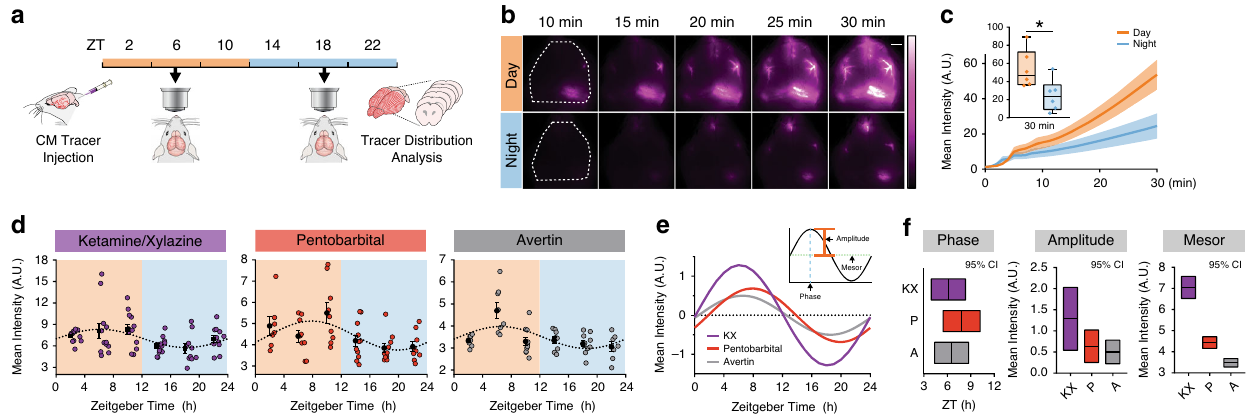
Fig. 1 Glymphatic in fl ux is higher during the day. a Schematic of experiment. b Representative images for in vivo recordings of CSF tracer in fl ux after injection in the CM either during the day (orange) or night (blue) under ketamine/xylazine (KX) anesthesia. Dotted white line indicates region of quanti fi cation in c . White scale bar: 2 mm. c Mean pixel intensity in arbitrary units (A.U.) over 30 min post CM injection. Thick lines indicate group means with SEM outlined in shaded regions. The inset is the magnitude of fl uorescence at 30 min with boxplots, minima is minimum value, maxima is maximum value, center is median and quartiles shown by box and whiskers, individual animals represented as colored dots, two-sided t test, p = 0.0257. Time 0 is tracer infusion start. n = 6 mice per group. Asterisk indicates p < 0.05. d Time course of mean pixel intensity from ex vivo coronal sections under KX (violet, n = ZT22: 10 mice; ZT18: 11 mice; ZT2, ZT6, ZT10, and ZT14: 12 mice), pentobarbital (red, n = ZT2: 7 mice; ZT6, ZT10, and ZT22: 9 mice; ZT18: 10 mice; ZT14: 11 mice), and Avertin (gray, n = ZT22: 7 mice; ZT2 and ZT6: 8 mice; ZT14: 9 mice; ZT10 and ZT18: 10 mice). Each colored point is an animal, black points are mean ± SEM for each time bin. Dotted line indicates estimated cosinor curve. The light cycle is indicated by orange (day) and blue (night) coloring in the background. Zeitgeber Time (ZT) in hours, where ZT0 is lights on and ZT12 is lights off. e Estimated cosine curves aligned at the mesor for KX, pentobarbital (P), and avertin (A), with an inset depicting measurements from a cosine curve. f 95% con fi dence intervals for estimates of phase, amplitude, and mesor for each anesthetic. Midline is the model generated estimate, bars indicate 95% range around the estimate. Source data are provided as a Source Data fi le.